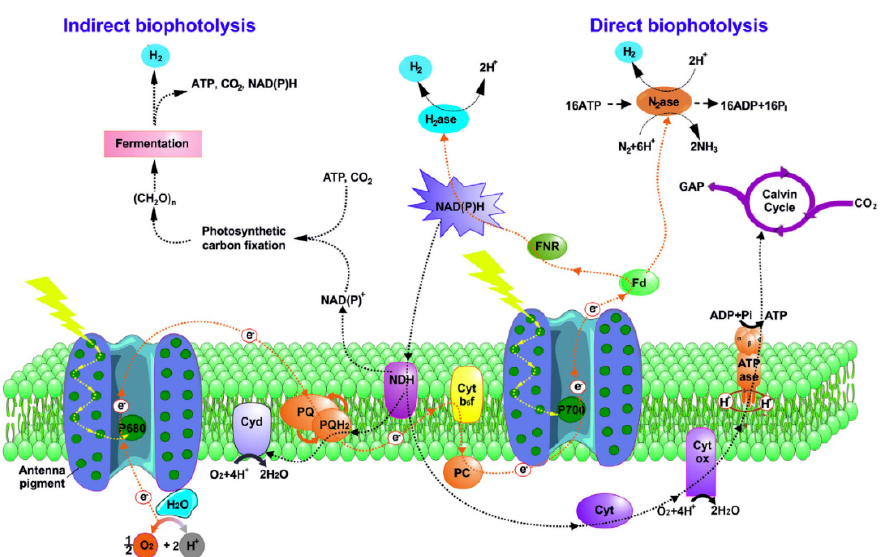
Figure 8. Direct and indirect biophotolysis processes of photosynthetic microorganisms Abbreviation: Cyd, cytochrome bd quinol oxidase; PQH 2 /PQ, plastoquinol/plastoquinone; ATPase, ATP synthase; Cyt b 6 f, cytochrome b 6 f complex; Fd, ferredoxin; FNR, ferredoxin NAD(P) reductase; H 2 ase, hydrogenase; NDH, NAD(P)H dehydrogenase; PC, plastocyanin; PQ, plastoquinones; P680, Photosystem II; P700, Photosystem I; N 2 ase, nitrogenase; H 2 , hydrogen [141].